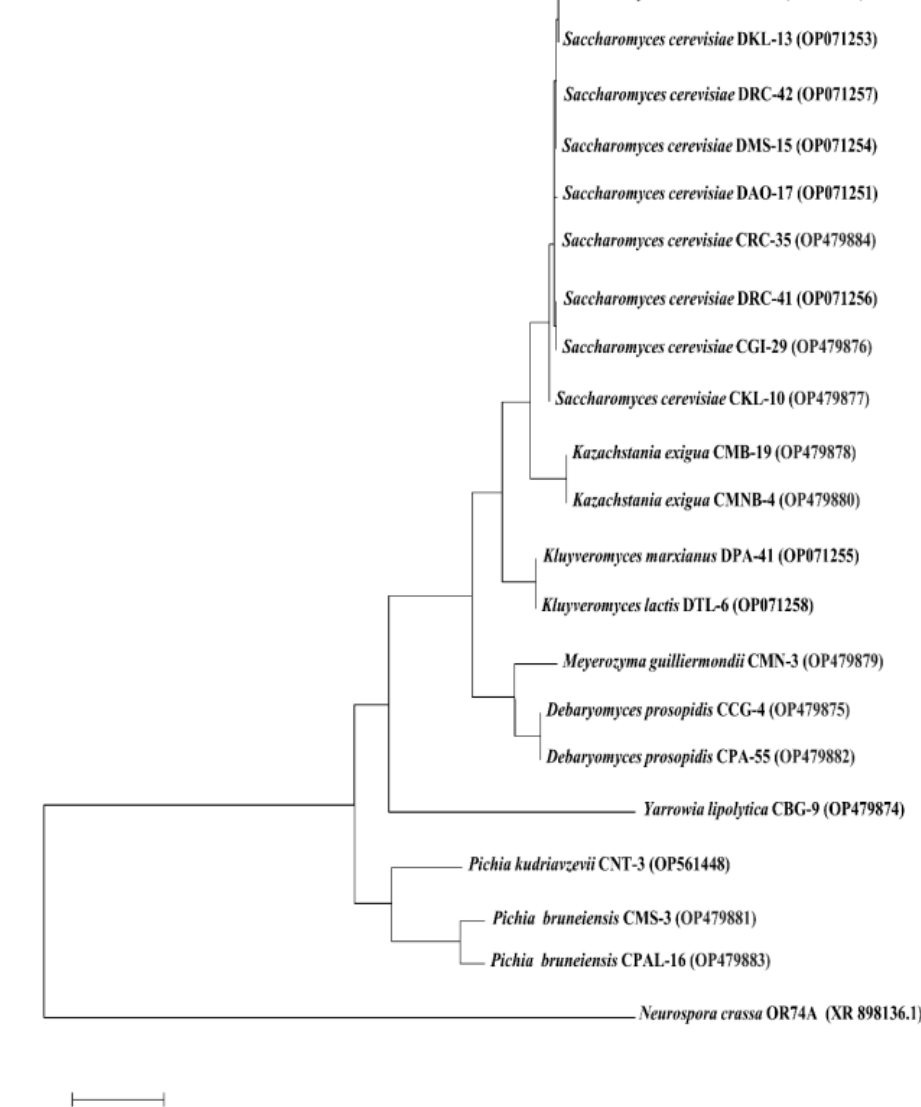
Figure 3. Molecular phylogenetic analysis of 8 yeasts from dahi and 12 yeasts from chhurpi based on sequencing of the D1/D2 domain of a large ribosomal subunit, by the neighbor-joining method using MEGA v11.0.13 with Neurospora crassa OR74A as the out group. Saccharomyces cerevisiae was the dominant probiotic yeast in the dahi samples, fol- lowed by Kluyveromyces marxianus and K. lactis, whereas S. cerevisiae, Debaryomyces prosopidis, Kazachstania exigua, Pichia bruneiensis, P. kudriavzevii, Meyerozyma guillier- mondii and Yarrowia lipolytica were detected in the chhurpi samples (Table Table 4. Molecular identification of probiotic yeasts strains isolated from dahi and chhurpi of Sikkim, based on sequencing of the D1/D2 domain of a large ribosomal subunit.